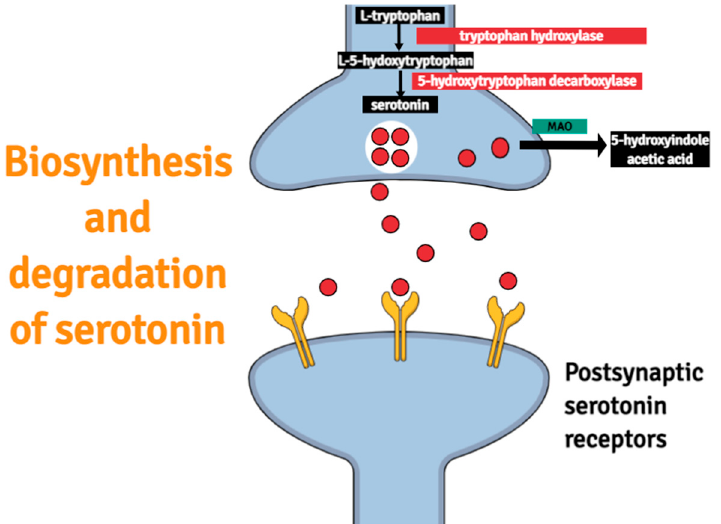
Figure 1. A scheme presenting a graphical interpretation of biosynthesis and degradation of serotonin. MAO stands for monoamine oxidase, an enzyme mainly responsible for the degradation of serotonin.